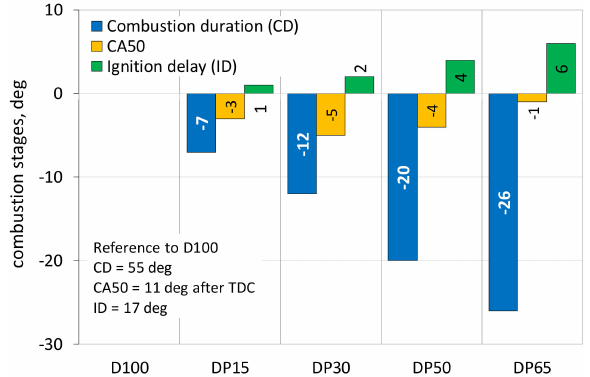
Figure 6. The stages of ID, CA50 and CD